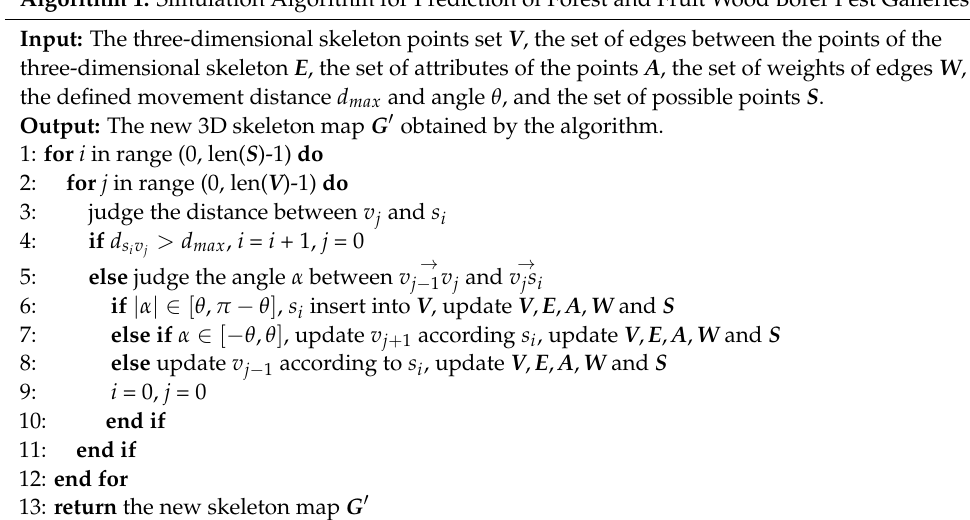
Algorithm 1. Simulation Algorithm for Prediction of Forest and Fruit Wood Borer Pest Galleries Input: The three-dimensional skeleton points set V , the set of edges between the points of the three-dimensional skeleton E , the set of attributes of the points A , the set of weights of edges W , the defined movement distance d max and angle θ , and the set of possible points S